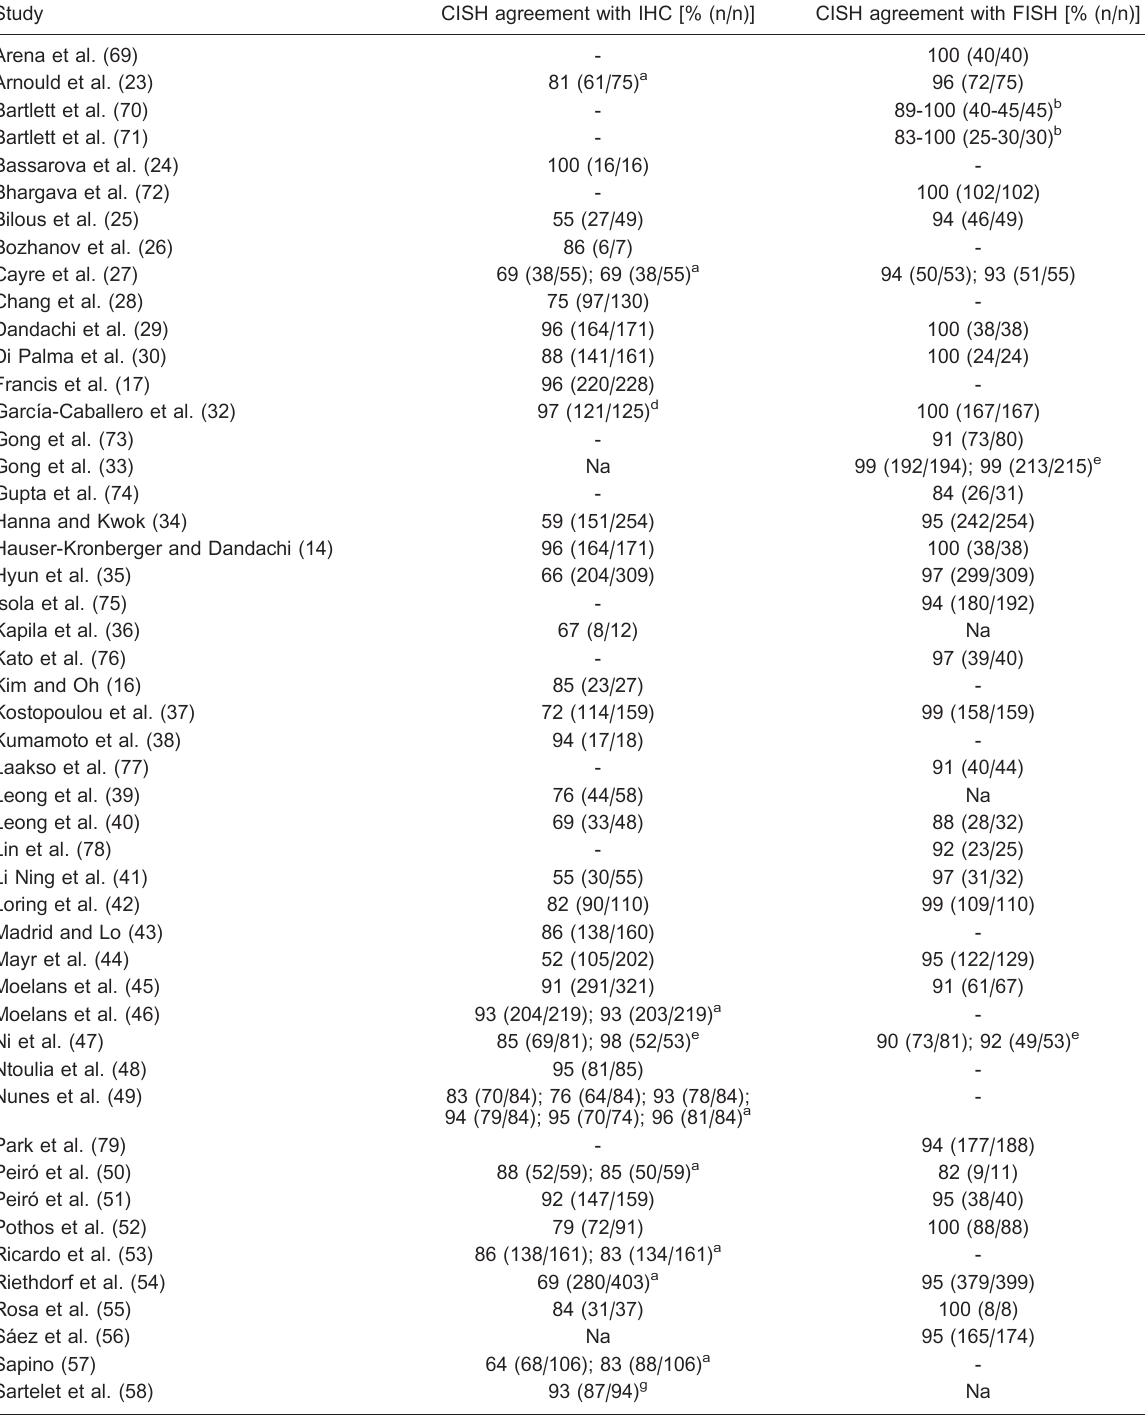
Table 1. Comparative analysis of chromogenic in situ hybridization (CISH), immunohistochemistry (IHC) and fluorescence in situ hybridization (FISH) results for breast cancer